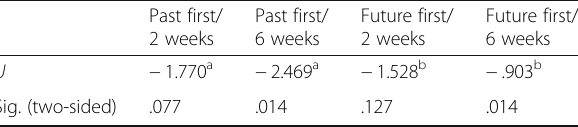
Table 6 Wilcoxon test for before and after responsibility scores per condition Past first/ 2 weeks